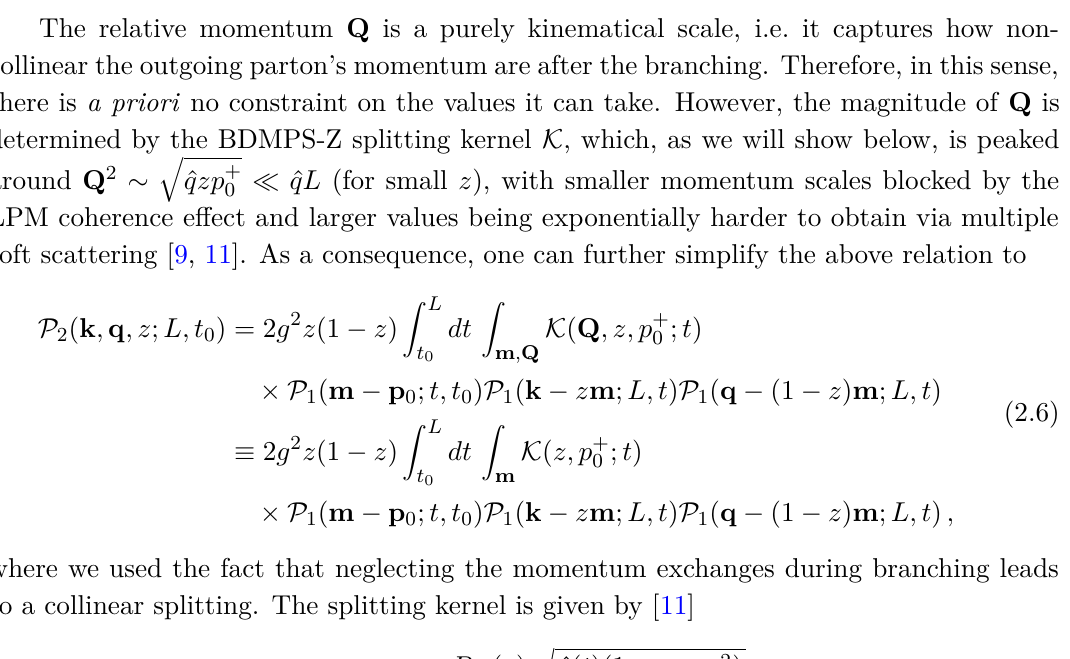
Figure 1 . Diagrammatic representation of eq. (2.4). The labels used follow the notation in the main text and the gray blob denotes the underlying QCD